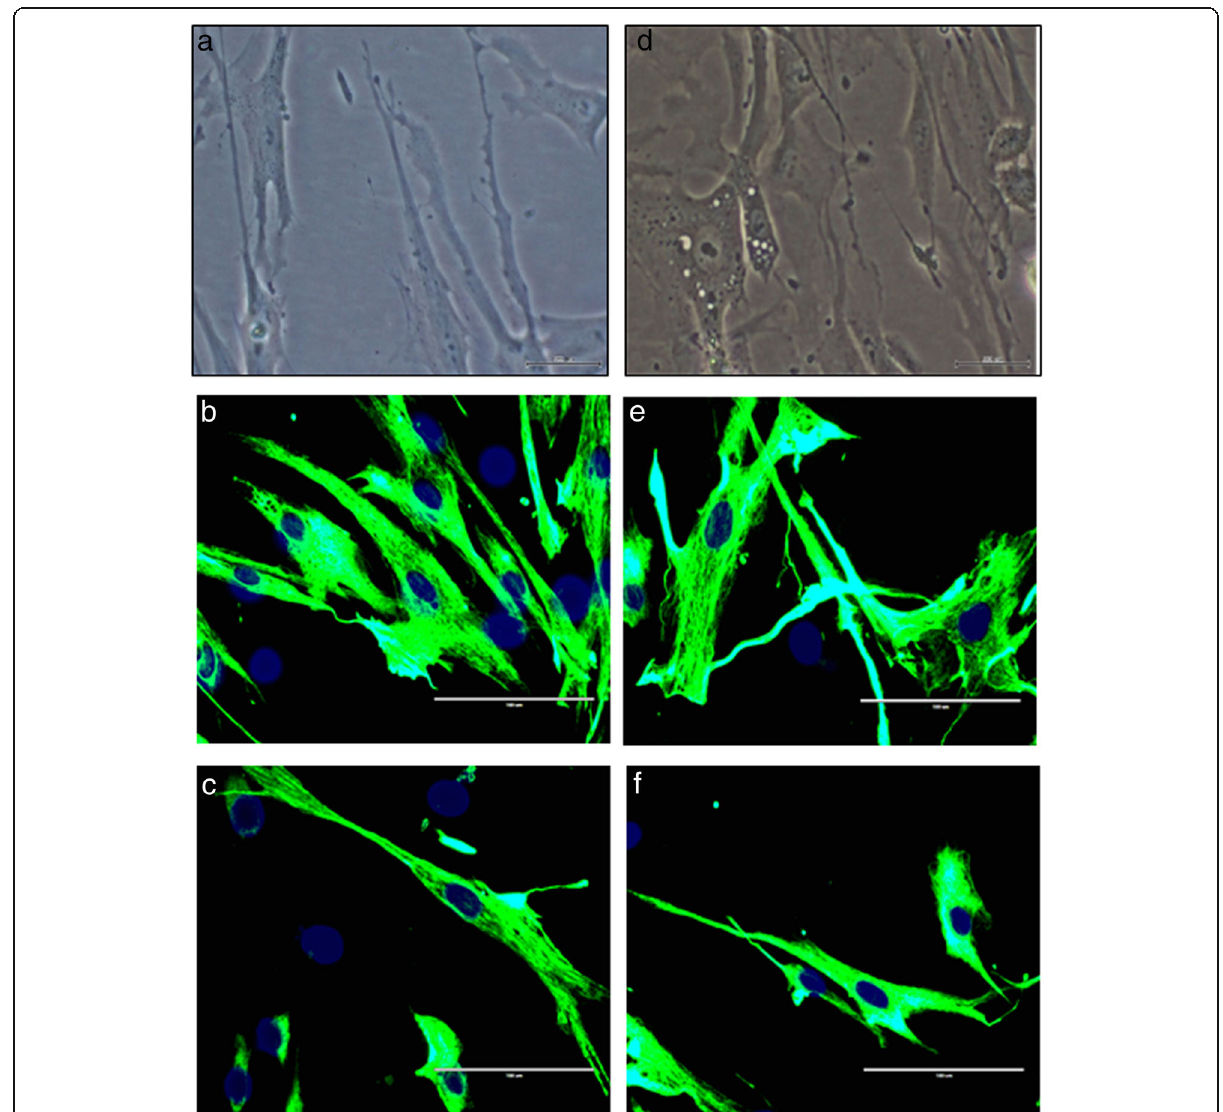
Fig. 1 Morphology of young and senescent myoblasts for control and TRF-treated cells. Observation was carried out under phase contrast ( a , d ) and fluorescence microscopy ( b , c , e , f ) (× 40 magnification). The myoblast cells were stained with an antibody against desmin (green), and the nuclei were stained with Hoechst (blue). Control senescent myoblasts appeared larger and flatter with the presence of more prominent intermediate filaments ( d , e ) compared to control young myoblasts ( a , b ). Some of the TRF-treated senescent myoblasts ( f ) remained spindle- shaped which resembled young control while some exhibited flatter and larger morphology. No morphological changes was observed for TRF- treated young myoblasts ( c )